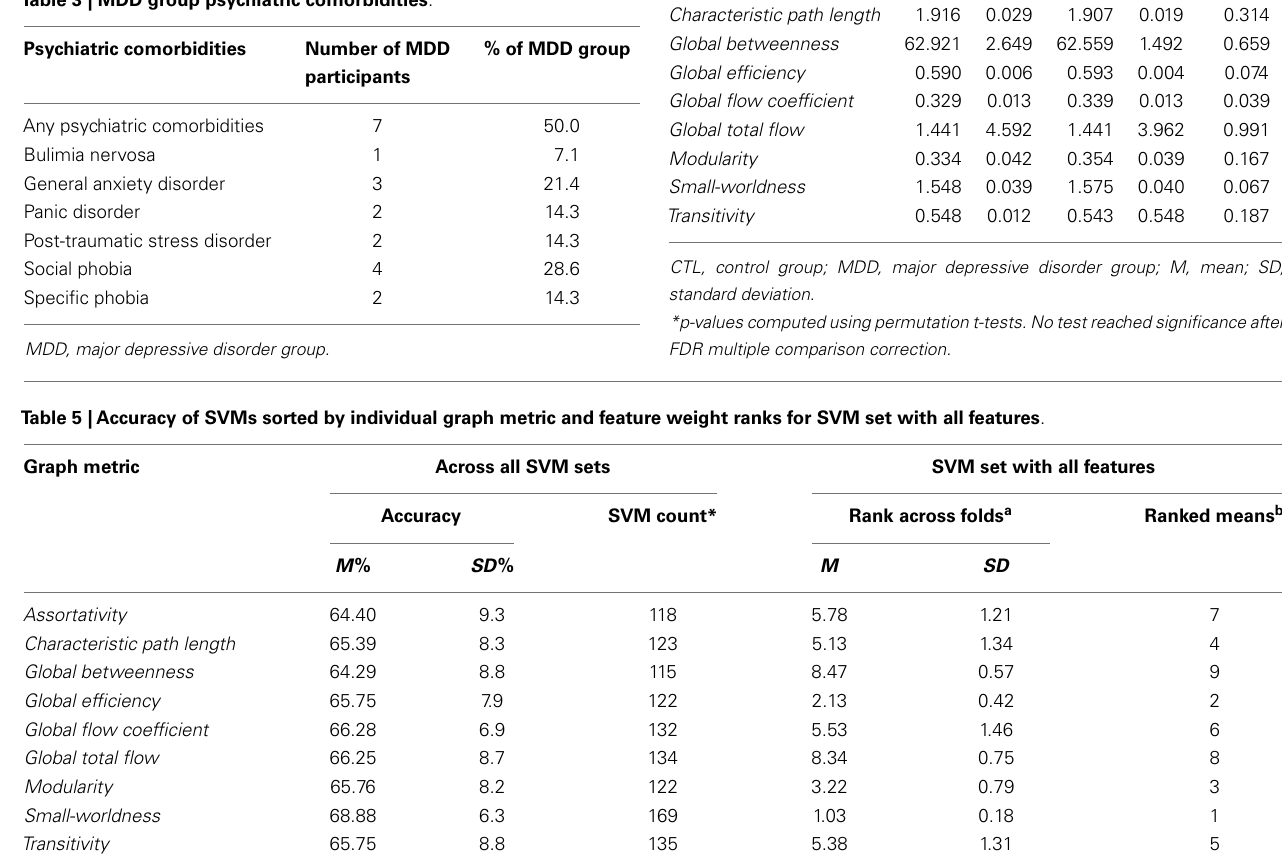
Table 3 | MDD group psychiatric comorbidities .